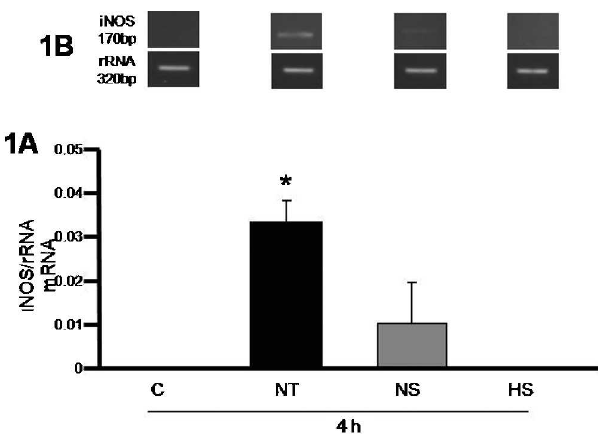
Figure 1 - Densitometric analysis of iNOS gene expression (1A), as assessed by PCR. iNOS mRNA expression was observed only at 4 h after the induction of pancreatitis. Representative mRNA iNOS (170-bp) and 18S rRNA (320-bp) bands (1B). Data are means ¡ SEM, n = 5 in each group. * P , 0.05 vs. C and HS.